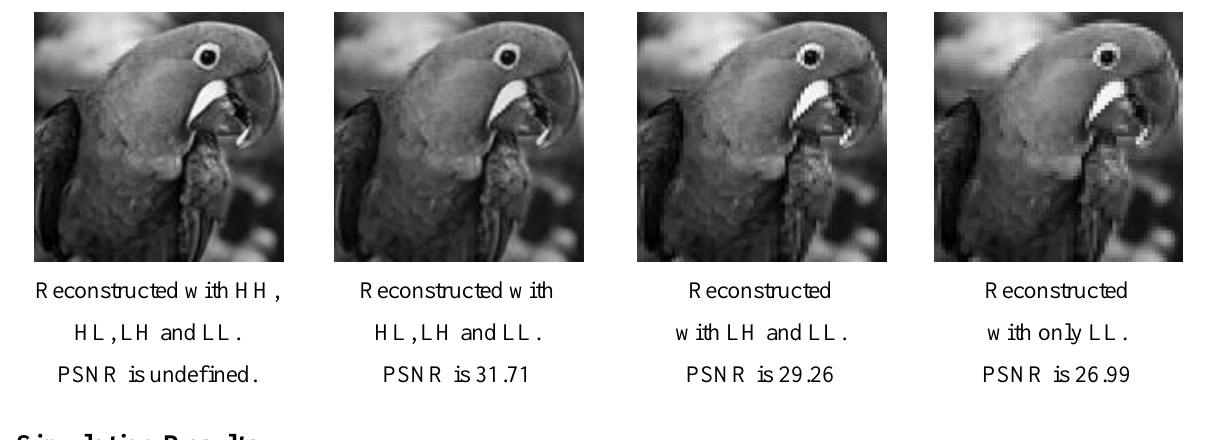
Figure 5. Different reconstructed images according to the considered 1-level 2D DWT